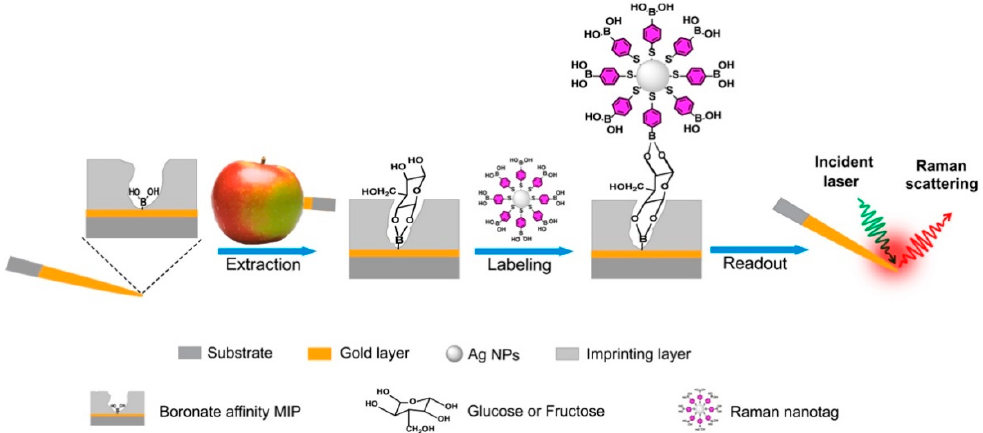
Figure 3. Schematic representation of microprobes prepared on gold-coated acupuncture needles via boronate affinity controllable oriented surface imprinting for glucose and fructose measurement in plant tissue by plasmonic affinity sandwich assay (PASA). Reproduced from Reference [72] with permission of Elsevier.